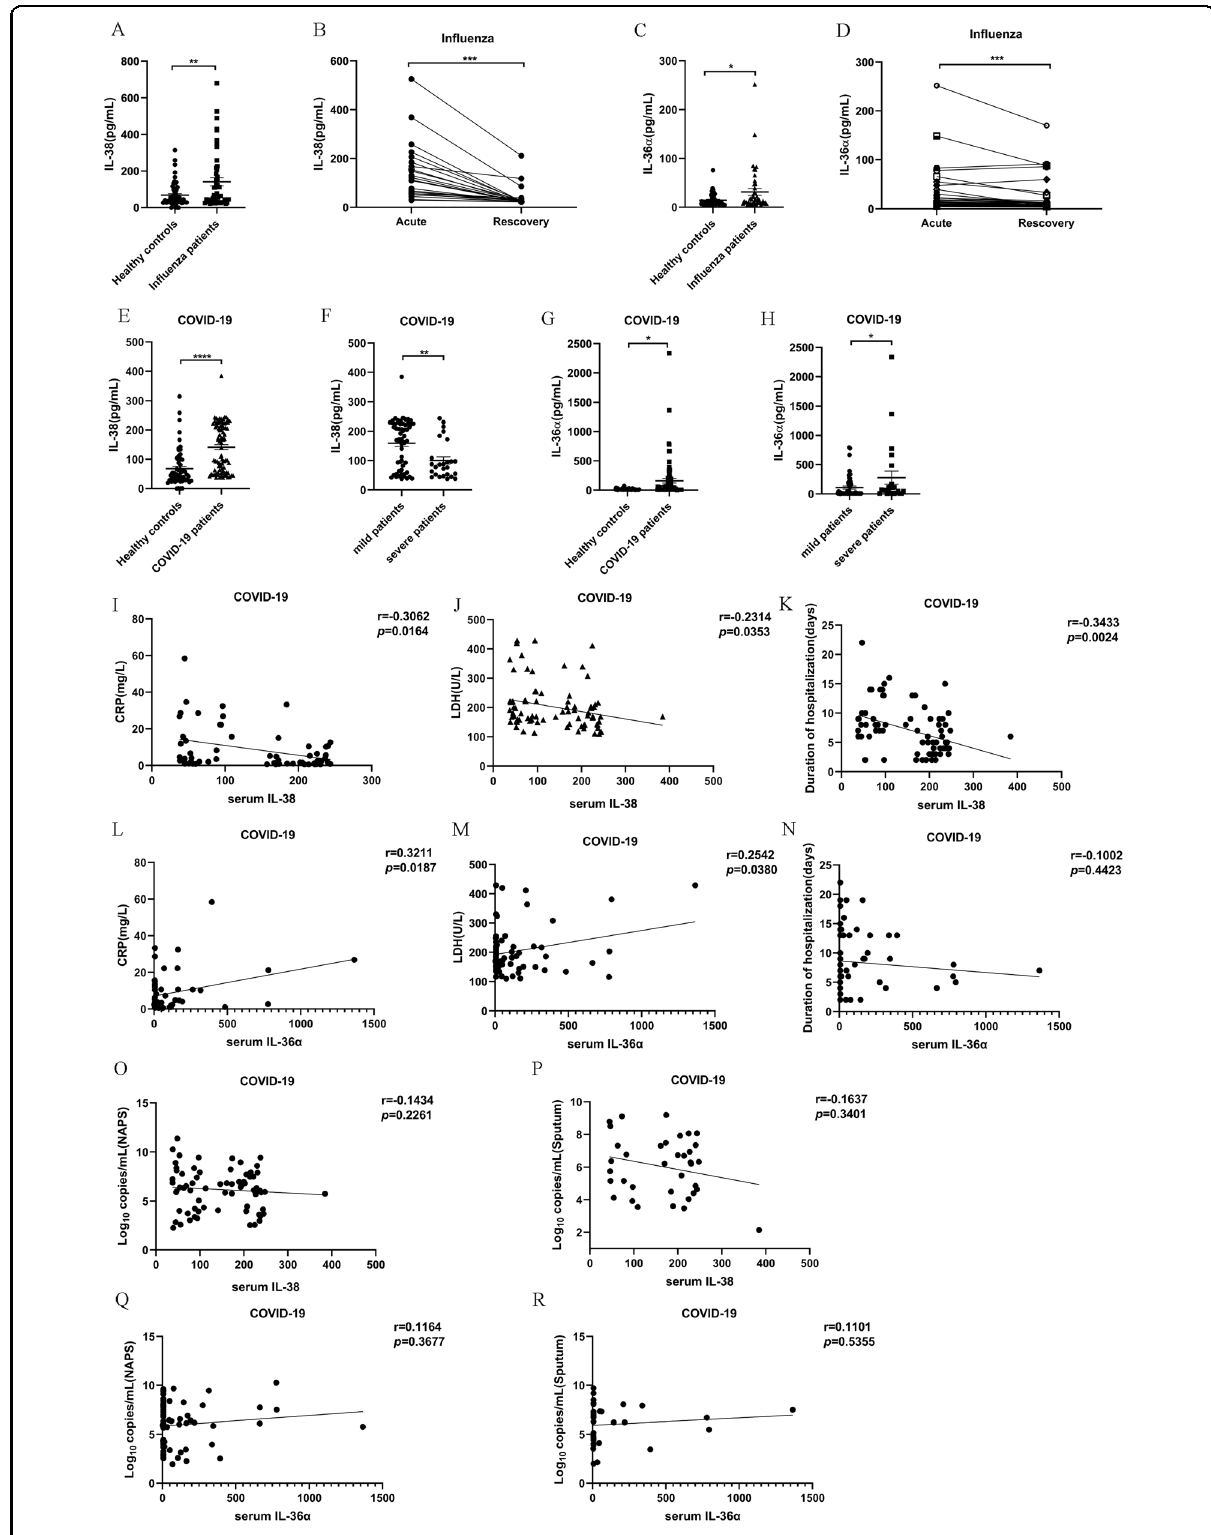
Fig. 6 (See legend on next